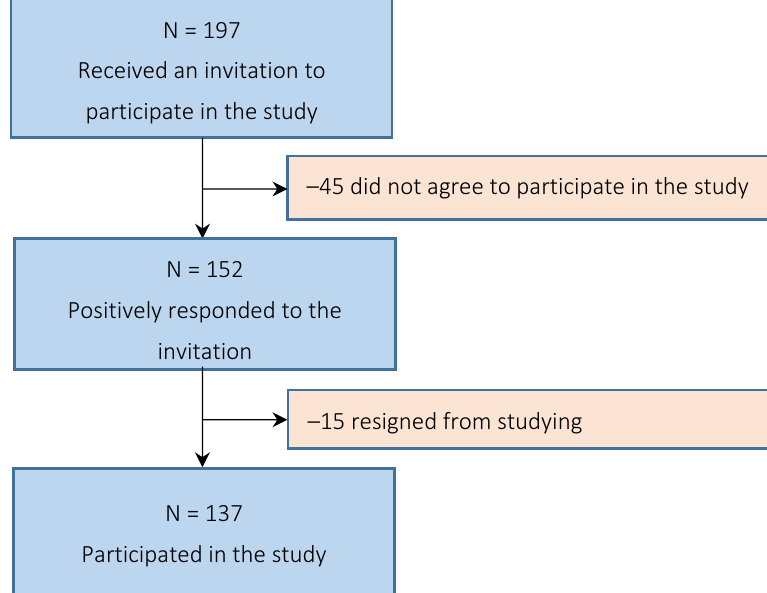
Figure 1. Flowchart of participant enrolment.